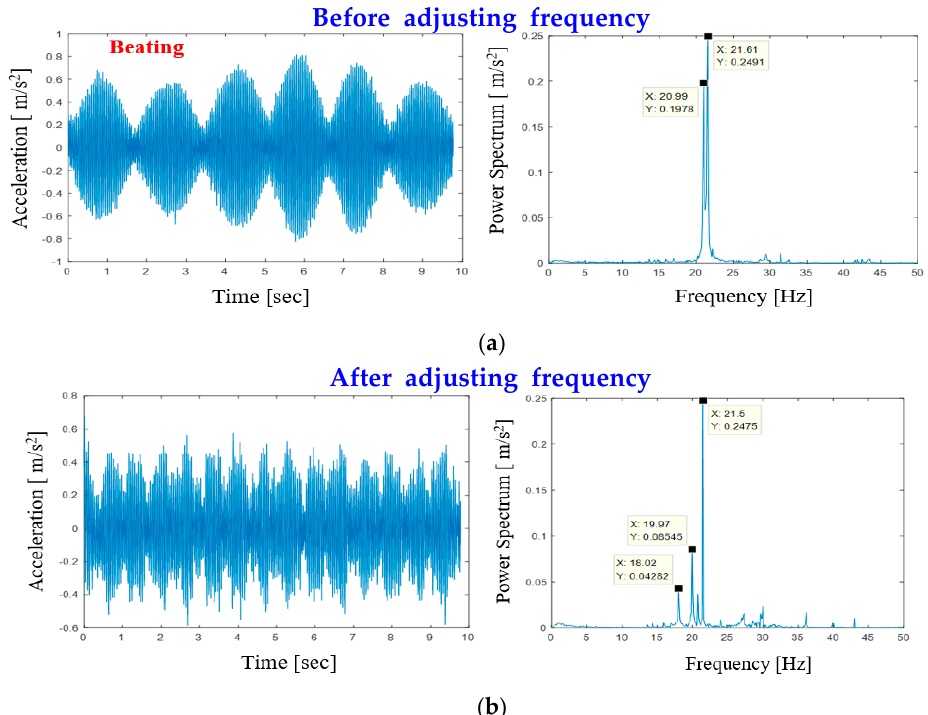
Figure 10. Vibration characteristics before and after adjusting driving frequencies of the sand units under full facilities operating condition at shipping control center: ( a ) Vibration responses at the shipping control center before adjusting driving frequency; ( b ) Vibration responses at the shipping control center after adjusting driving frequency.